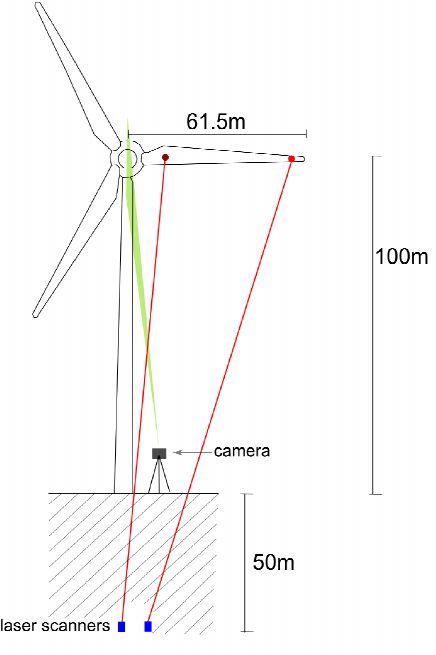
Figure 3. Measuring arrangements on